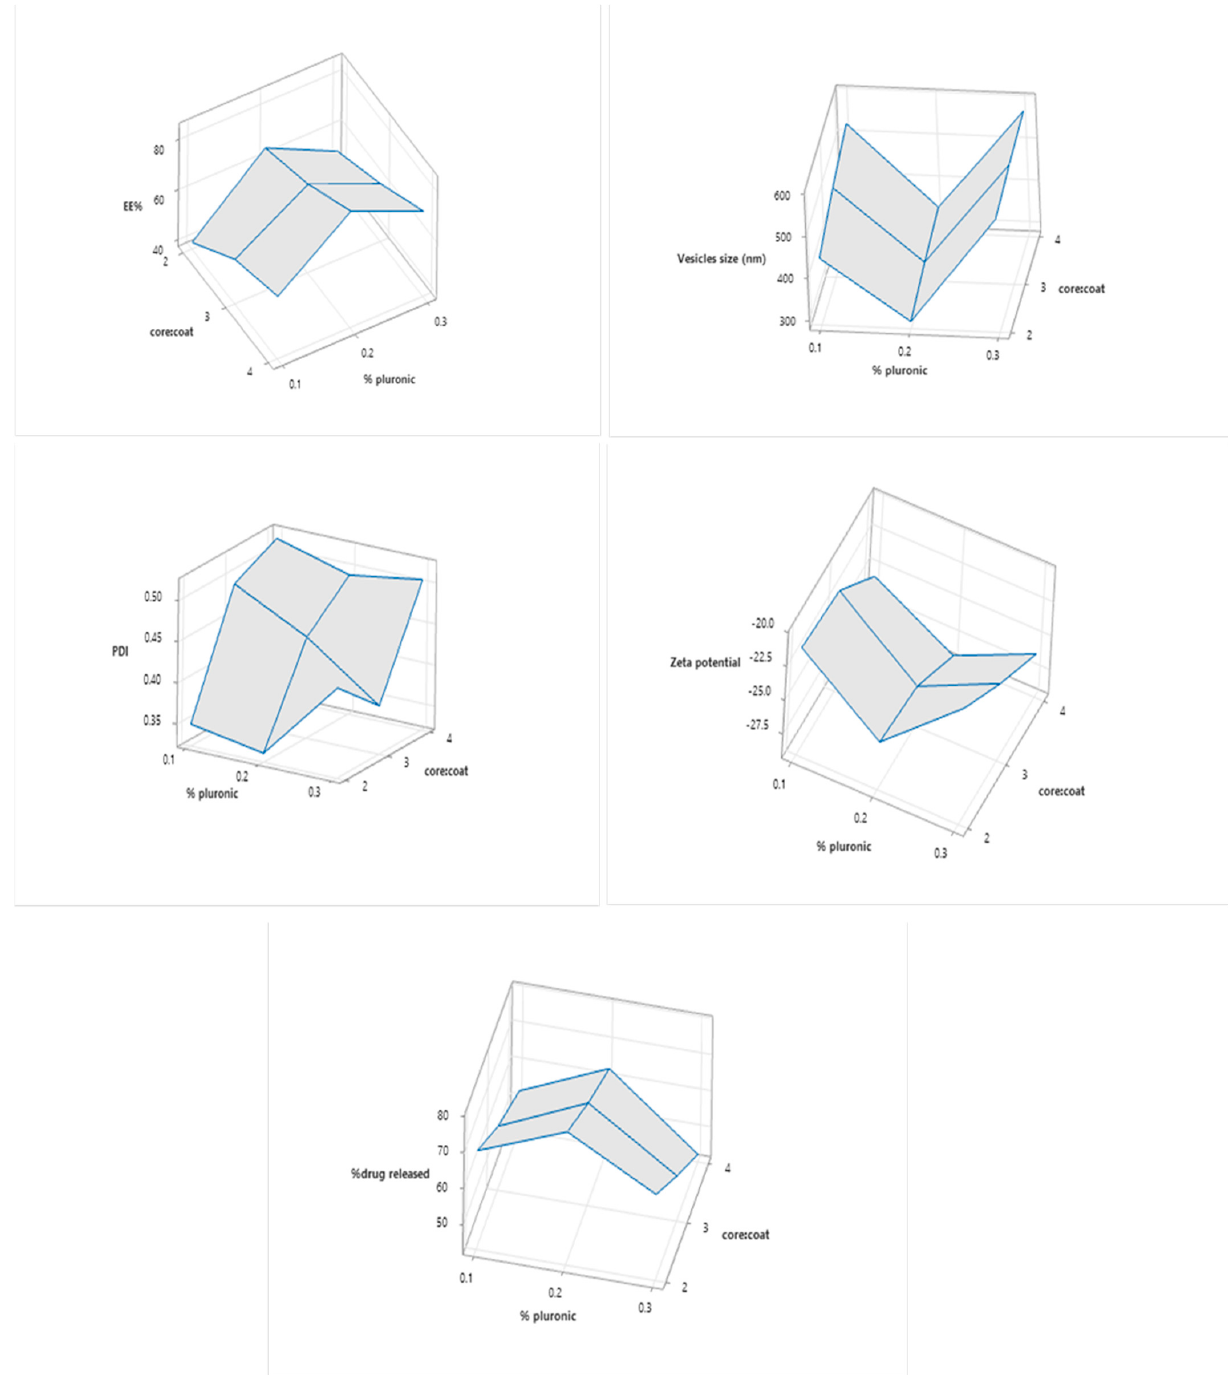
Figure 1. Combined effects of the independent variables on EE, particle size, PDI, zeta potential, and % drug